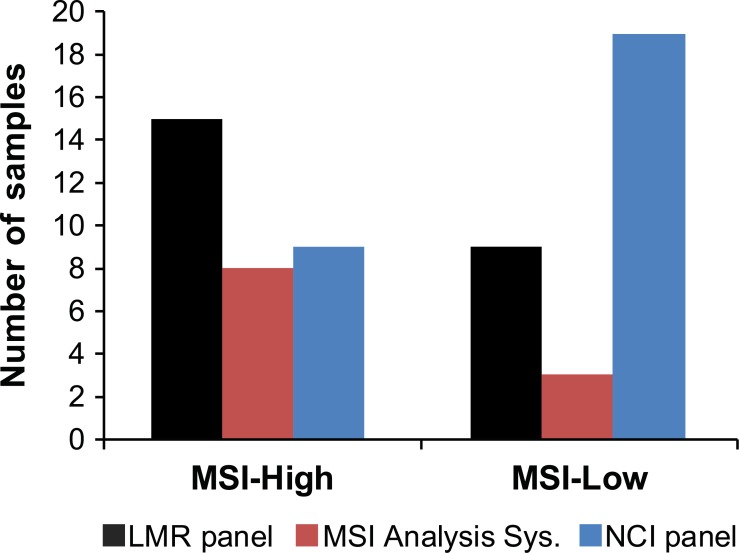
Use of LMR markers increased detection of MSI-High colonic lesions by 1.7 to 1.9 fold over currently used MSI markers.Three marker panels were used to screen lesions from 160 patients for MSI, including the experimental LMR panel, the MSI Analysis System and the NCI panel and the. Samples with two or more markers out of five unstable were considered MSI-High and one marker out of five as MSI-Low.